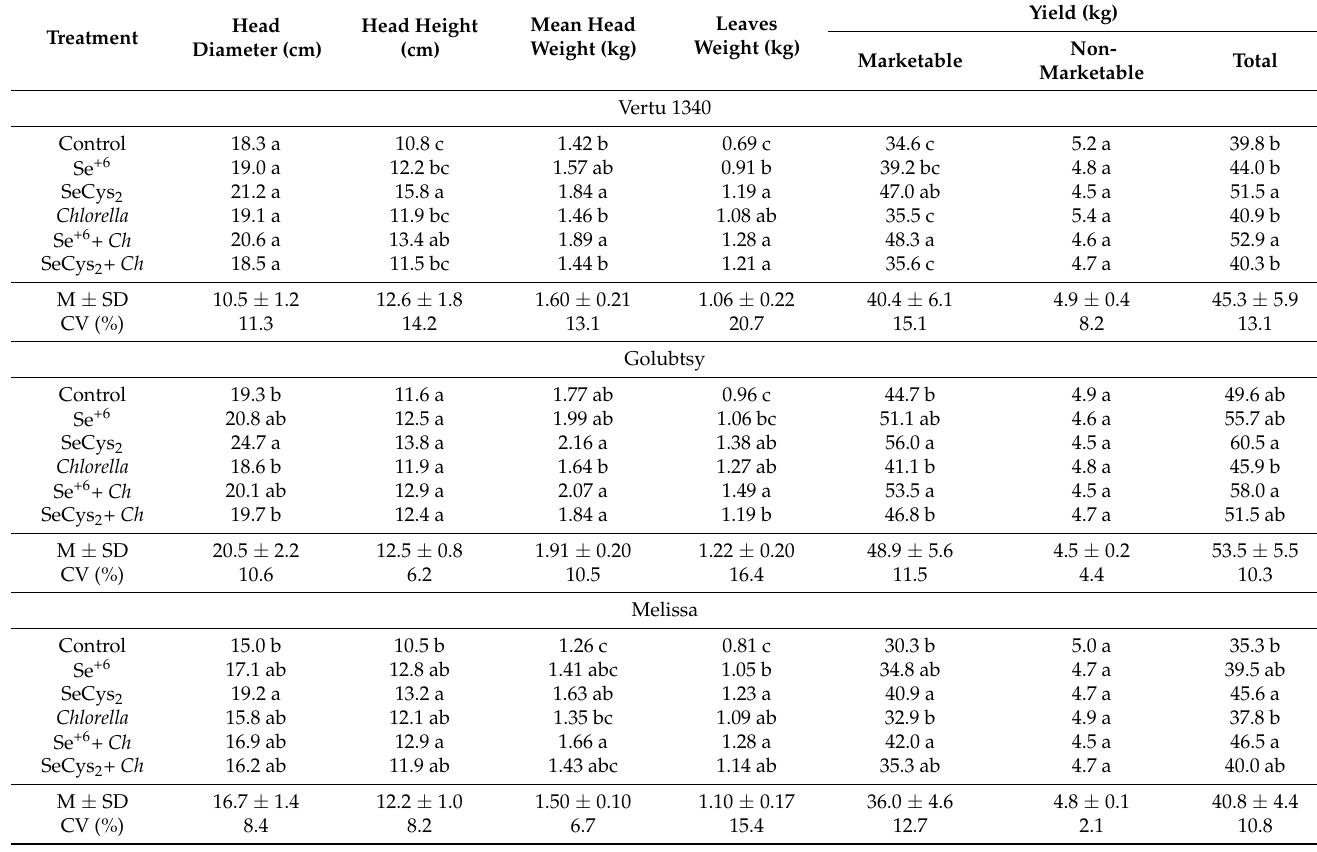
Table 1. Morphological characteristics and yield of Savoy cabbage biofortified by different forms of Se under Chlorella